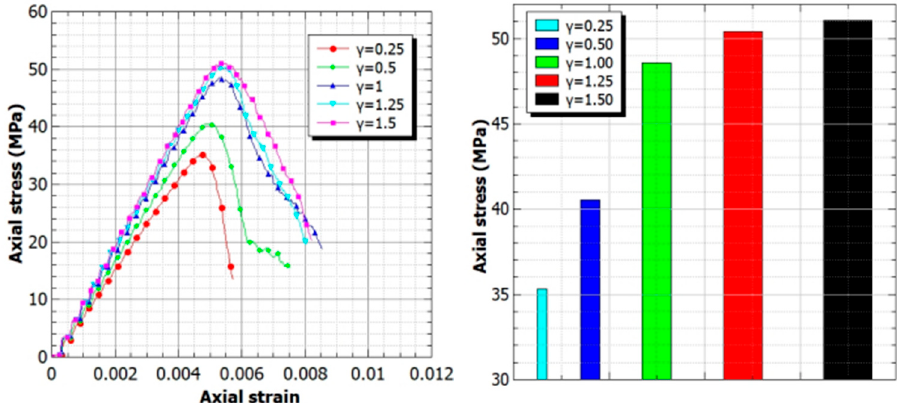
Figure 12. Axial stress, axial strain curves of tested specimens in Group 4.